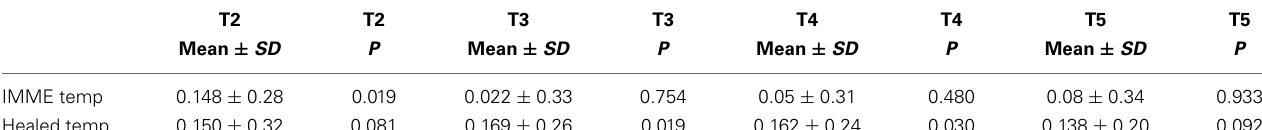
Table 3 | MBL difference between mesial and distal measurements at different time points (in mm).